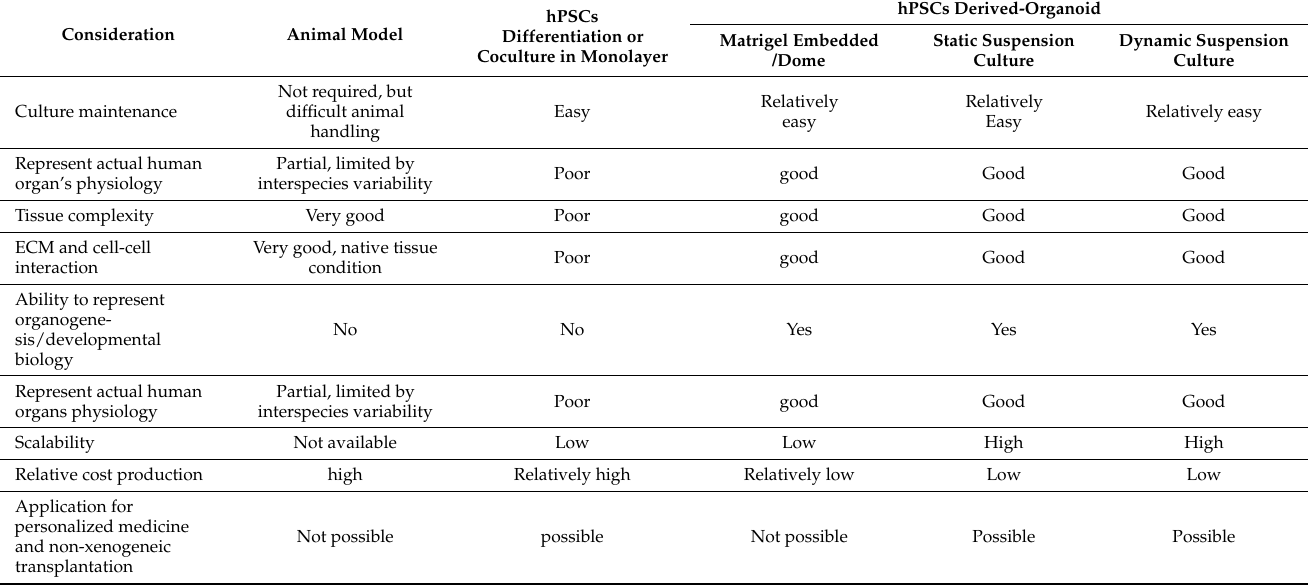
Table 2. A brief comparison of the common culture platform for organoid